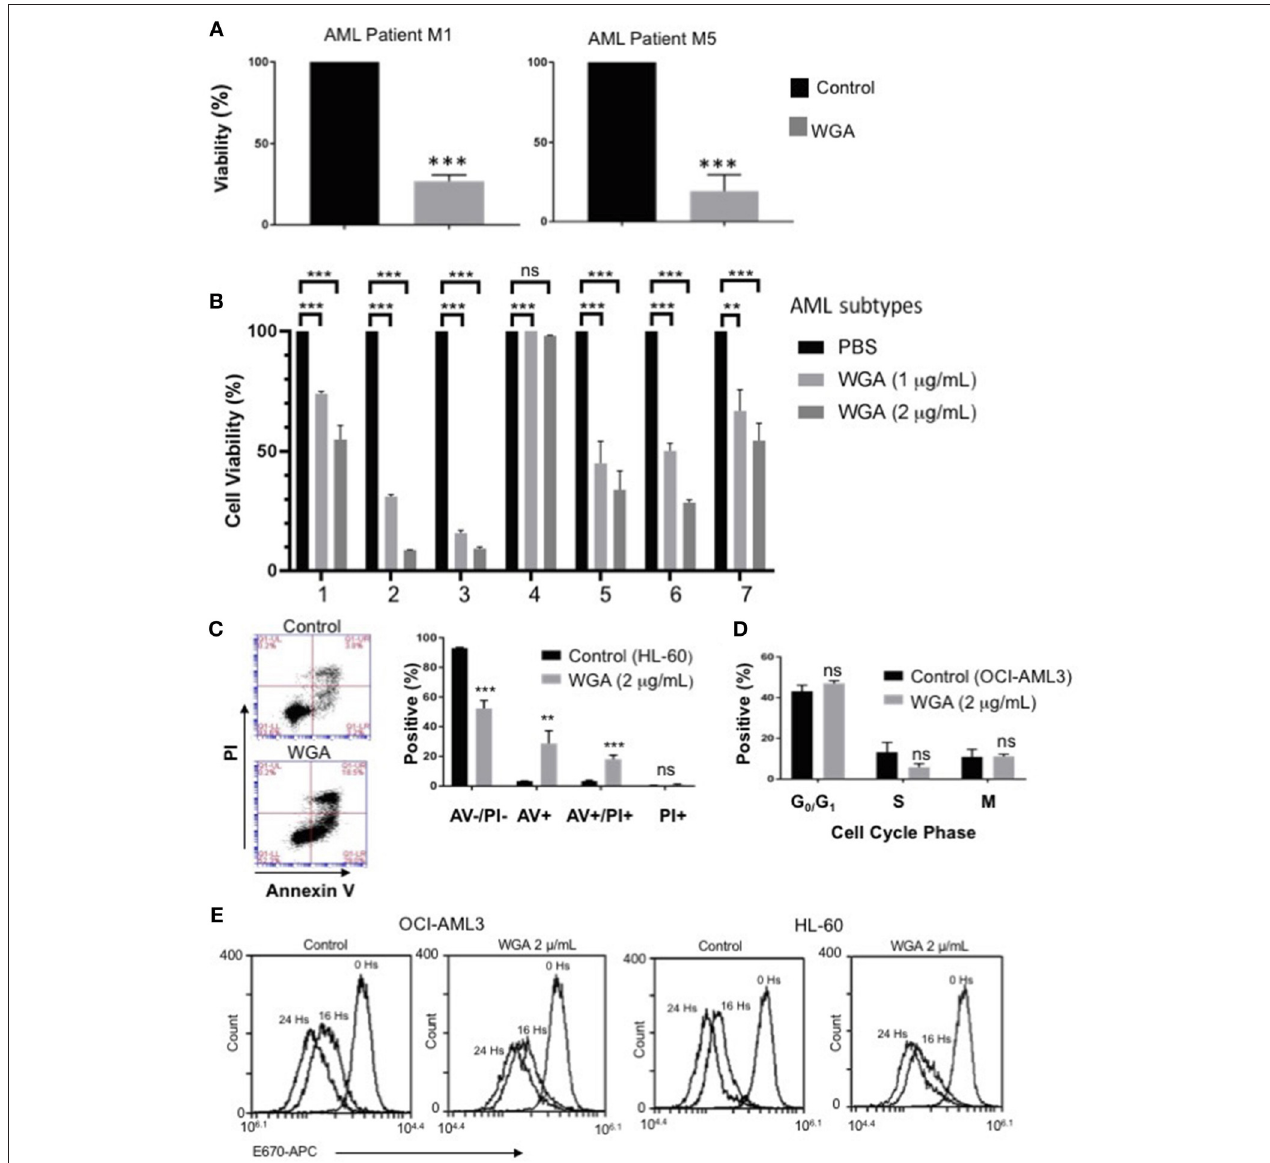
FIGURE 3 | WGA is toxic to primary patient cells and kills AML cells without altering cell cycle. (A,B) Percent viability calculated using FSC/SSC live gating of primary AML patient cells belonging to different subtypes (A) M1&M5 (B) M4Eo; inv16 (1), AML with MDS related changes (2), M2 with MDS-related changes (3), M2(4), CEBPA;c-Kit;TET2(5), NPM1;IDH1(6), IDH1;DNMT3a;FLT3-TKD;trisomy8(7) all treated with or without 2 µ g/mL WGA for 24h. Control was standardized to one hundred percent. (C) Annexin V/Propidium Iodide staining of HL-60 cells treated with WGA (2.0 µ g/mL) for 24h. (D) Cell cycle analysis of gated live OCI-AML3 cells treated with WGA (2 µ g/mL) for 24h. (E) E-670 cell proliferation assays using OCI-AML-3 and HL-60 cell lines in media alone or in the presence of 2.5 µ g/mL WGA for the indicated times. Proliferation of live cells was assessed via flow cytometry (Accuri 6C). ** p < 0.01, *** p < 0.001, and ns > 0.05.